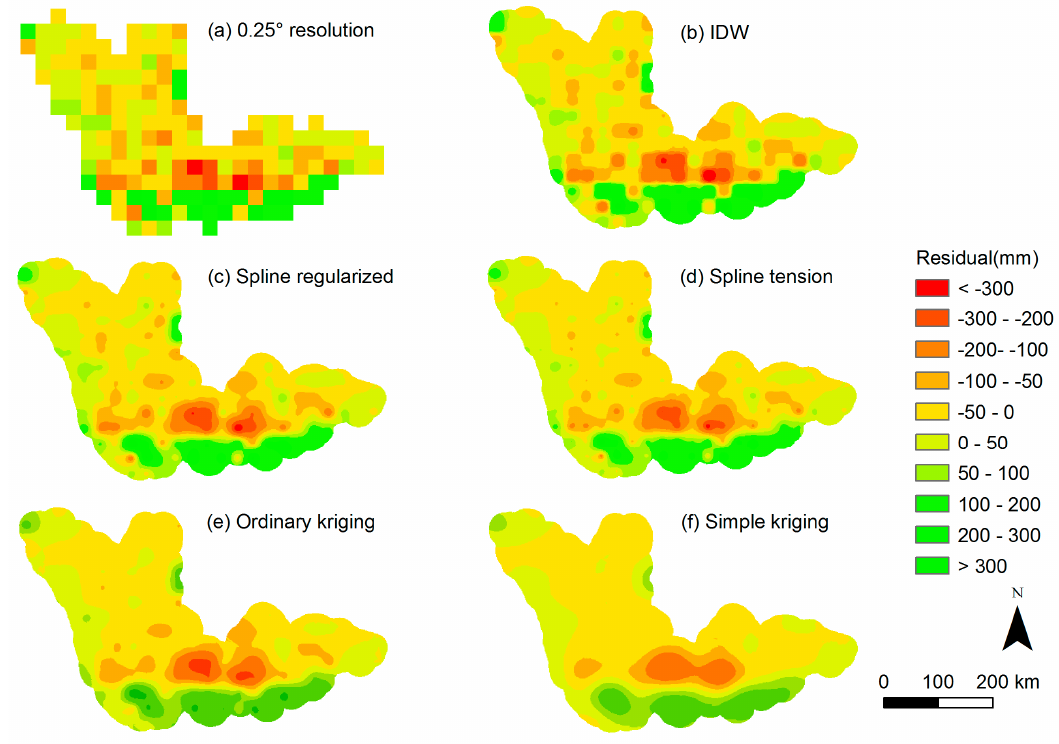
Figure 8. Spatial patterns of precipitation residuals between estimated precipitation by GWR and the TRMM-based precipitation of 0.25° spatial resolution using different spatial interpolation methods: ( a ) original grid residual map of 0.25° resolution; ( b ) the IDW interpolation method; ( c ) the simple spline regularized interpolation; ( d ) the simple spline tension interpolation; ( e ) the ordinary kriging interpolation method; and ( f ) the simple kriging interpolation method. Table 2. Evaluation of different interpolation methods for residual based on GWR model’s output (95% confidence intervals are in parentheses).